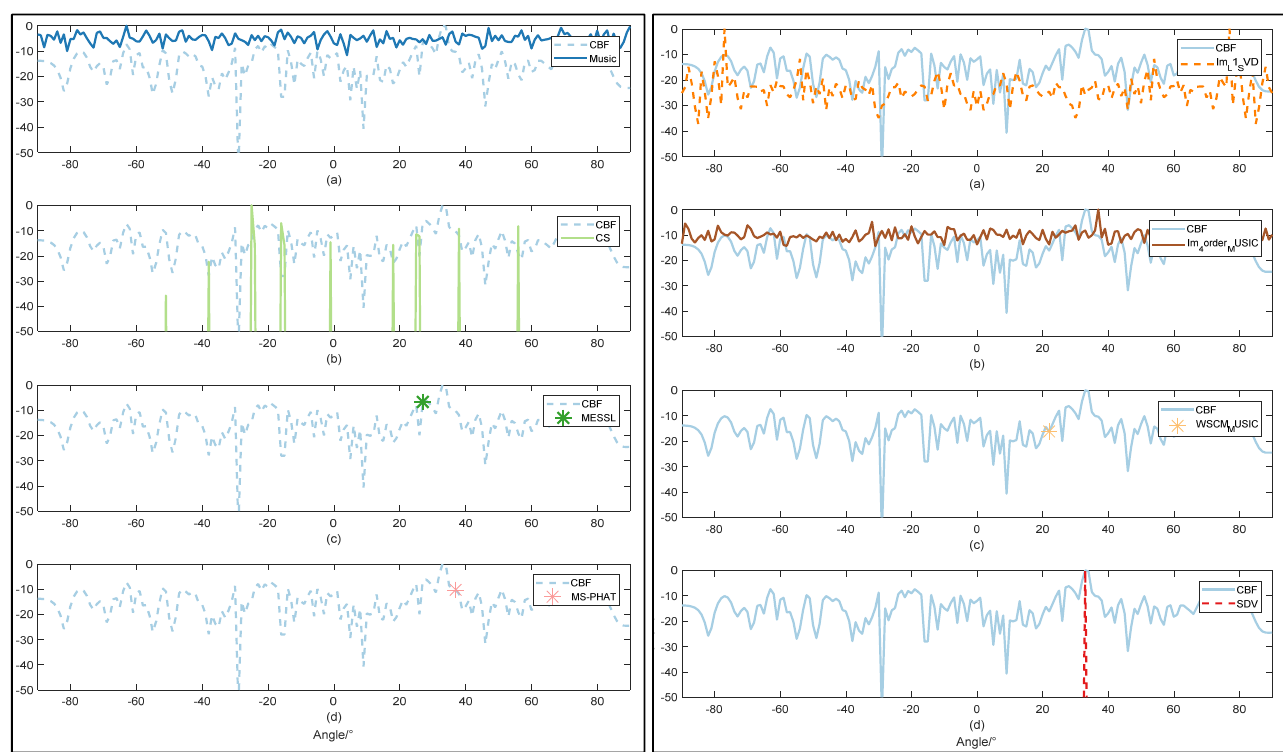
MUSIC are shown in right ( b ). WSCM-MUSIC are shown in right ( c ) and proposed SDV are shown in right ( d ).